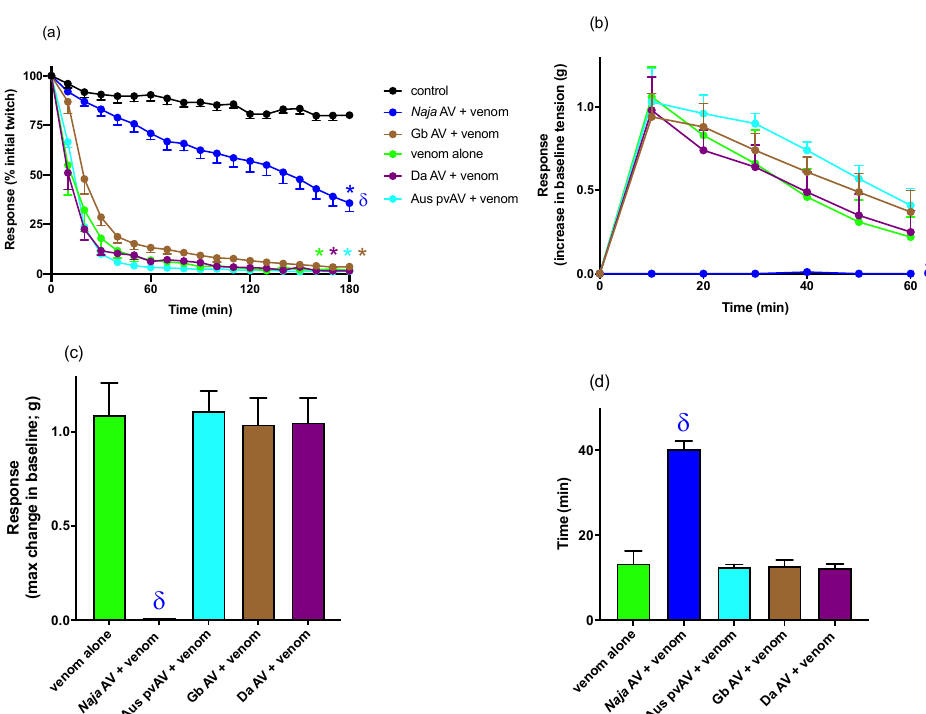
Figure 4. The myotoxic effects of Naja atra venom (30 µg/mL), in the presence and absence of different antivenoms, as indicated by the ( a ) change in twitch height in chick biventer cervicis preparation over 180 min; ( b ) change in baseline tension of the chick biventer cervicis preparation over 60 min; ( c ) max change in baseline gram tension achieved in 60 min; and ( d ) the time achieve max change in baseline tension. * p < 0.05, significantly different compared to control ( a ) at 180 min. δ p < 0.05, significantly different compared to venom alone at 180 min ( a ) or 60 min ( b ) or compared to venom in the absence of antivenom ( c , d ). n = 5–6. Antivenoms were added 10 min prior to venom. N. atra antivenom ( Naja AV); G. brevicaudus antivenom AV (Gb AV); D. acutus antivenom AV (Da AV); Australian polyvalent AV (Aus